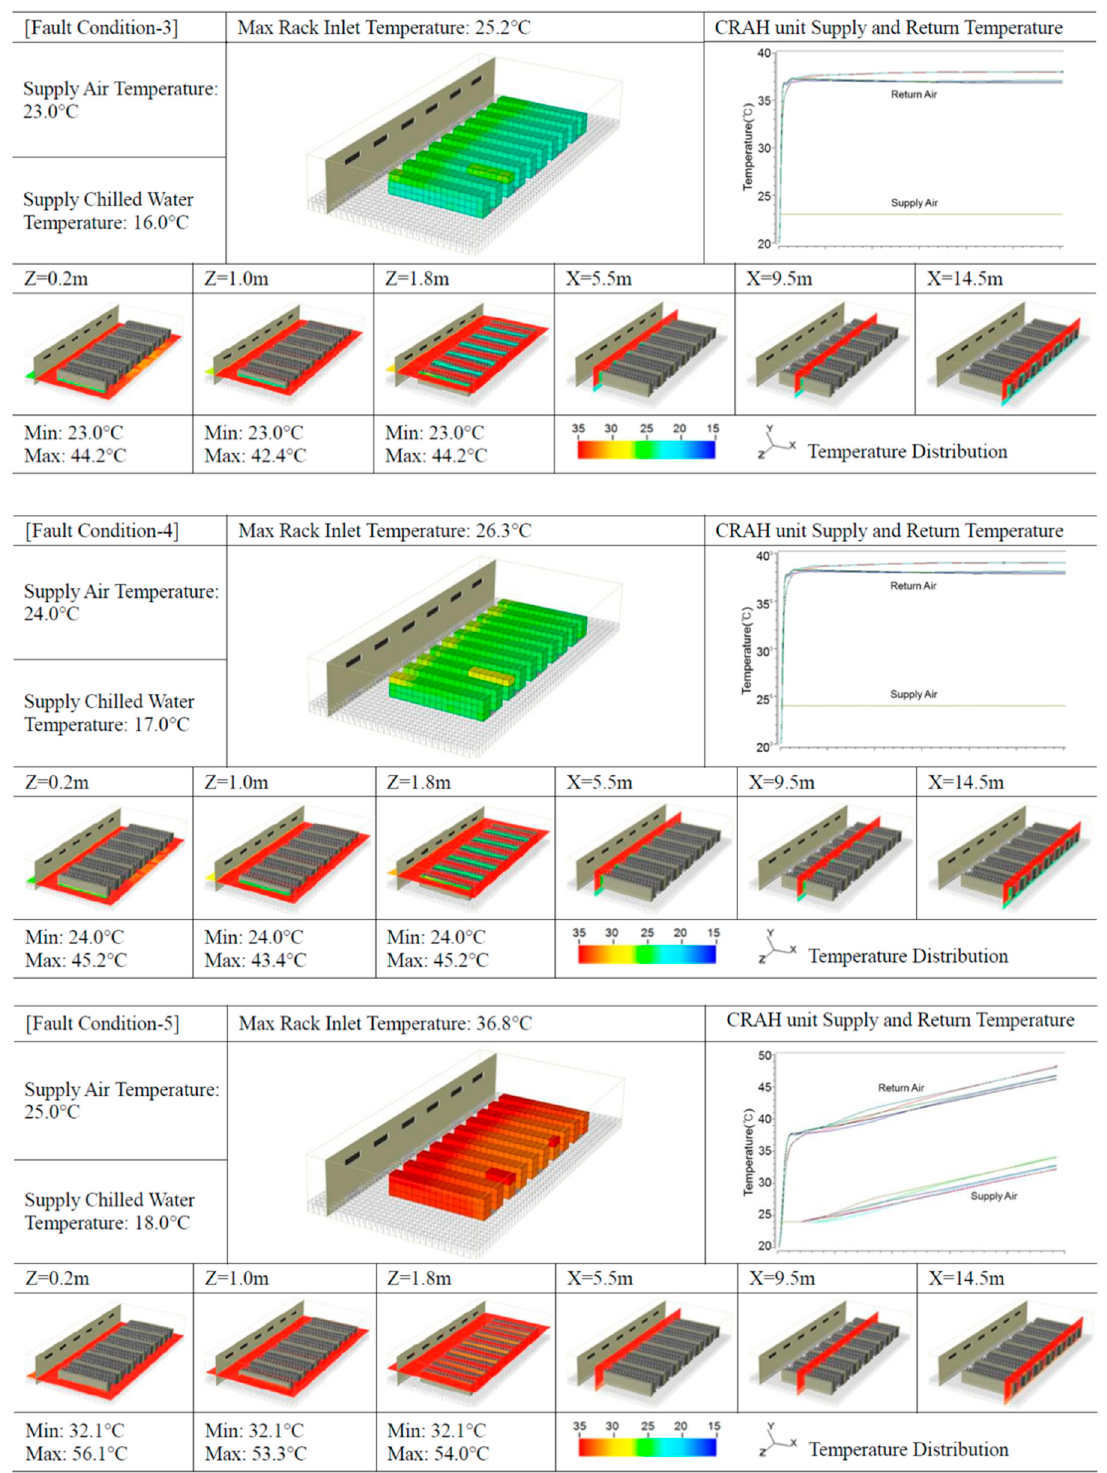
Figure 11. CFD simulation results for fault conditions 3, 4, and 5.